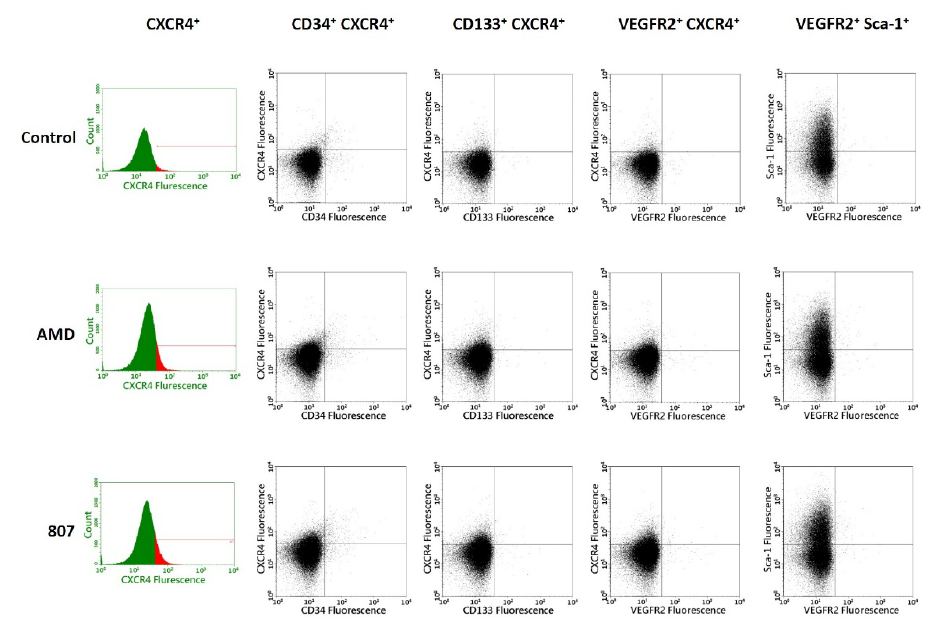
Figure A2. Gating strategies and FACS plots of AMD3100 and DBPR807.